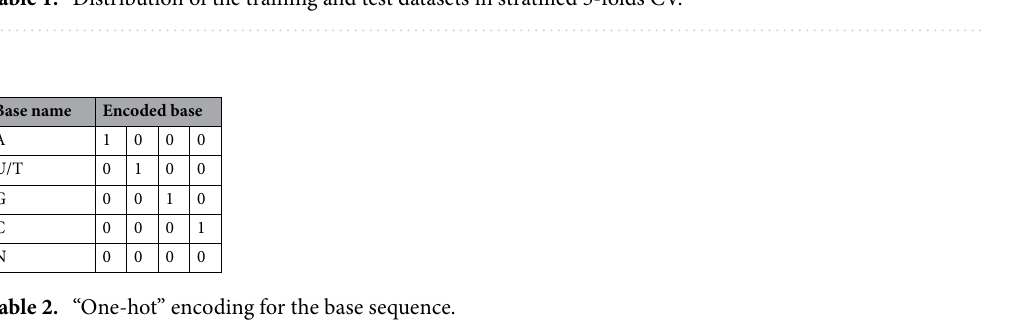
Table 1. Distribution of the training and test datasets in stratified 5-folds CV.